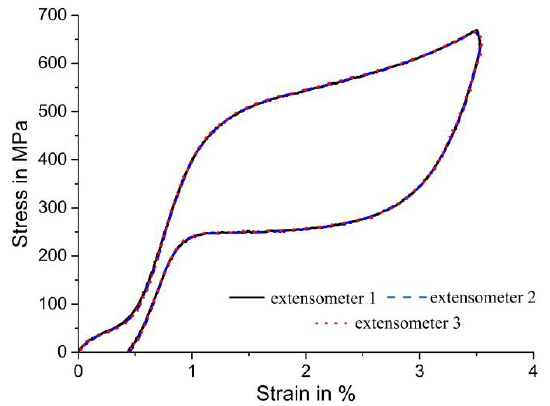
Figure 6. Engineering stress–strain curves determined using various virtual extensometers under simple compression. The different positions and gauge lengths of the virtual extensometers (see Figure 5) have no effect on the resulting stress–strain curves due to the very homogeneous deformation of pseudoelastic NiTi in compression.